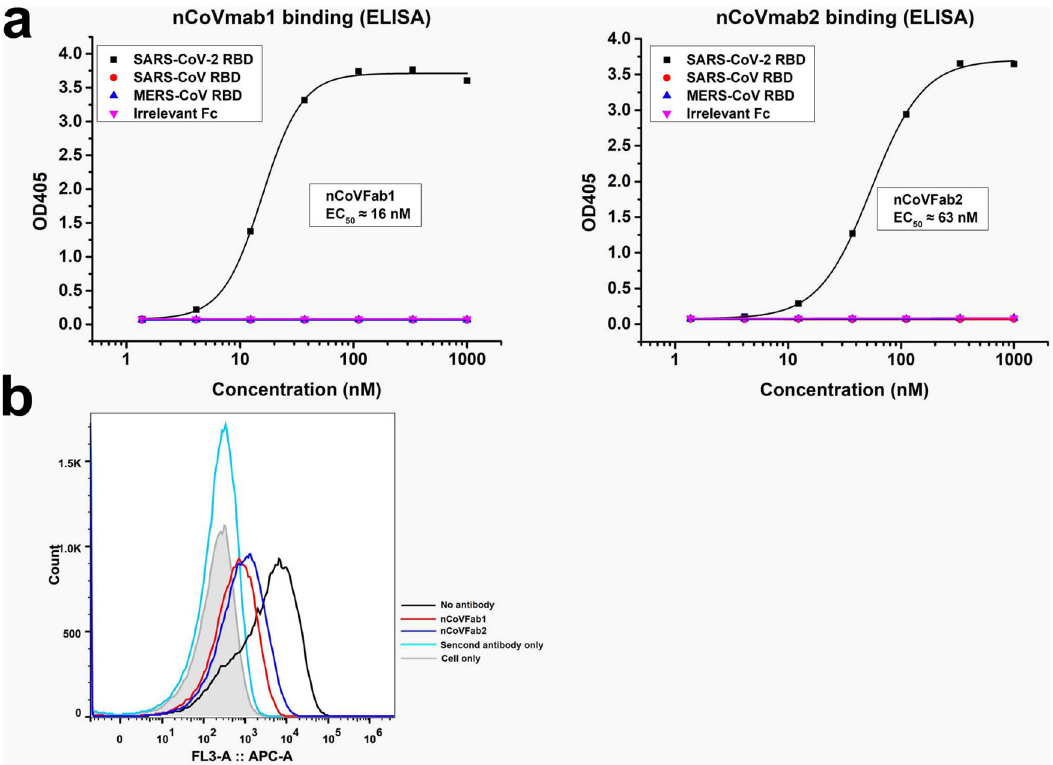
Fig. 1 Binding of nCoVFab1 and nCoVFab2 to RBDs. a Binding of nCoVFab1 and nCoVFab2 to different RBDs, as measured by an ELISA. RBD-Fc fusions of SARS-CoV-2, SARS-CoV, and MERS-CoV were used as antigens. Irrelevant Fc protein was used as a negative control. The experiments were performed independently twice and similar results were obtained. One representative experiment is shown and data are average values of two replicates. b Blockage of binding of SARS-CoV-2 RBD-Fc to Vero E6 cells by Fabs. nCoVFab1 and nCoVFab2 inhibited the binding fl uorescence shift with ef fi ciencies of approximately 89% and 82%, respectively, as measured by fl ow